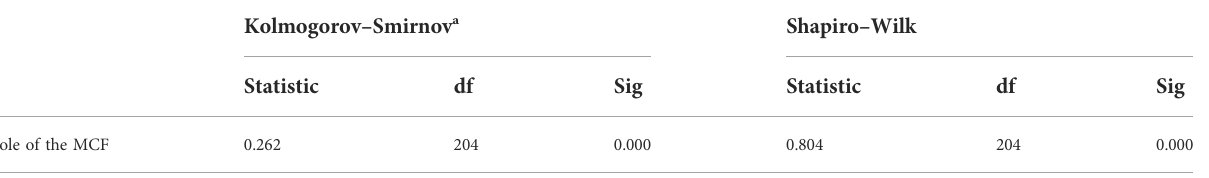
TABLE 1 Test of normality for identifying the role of the